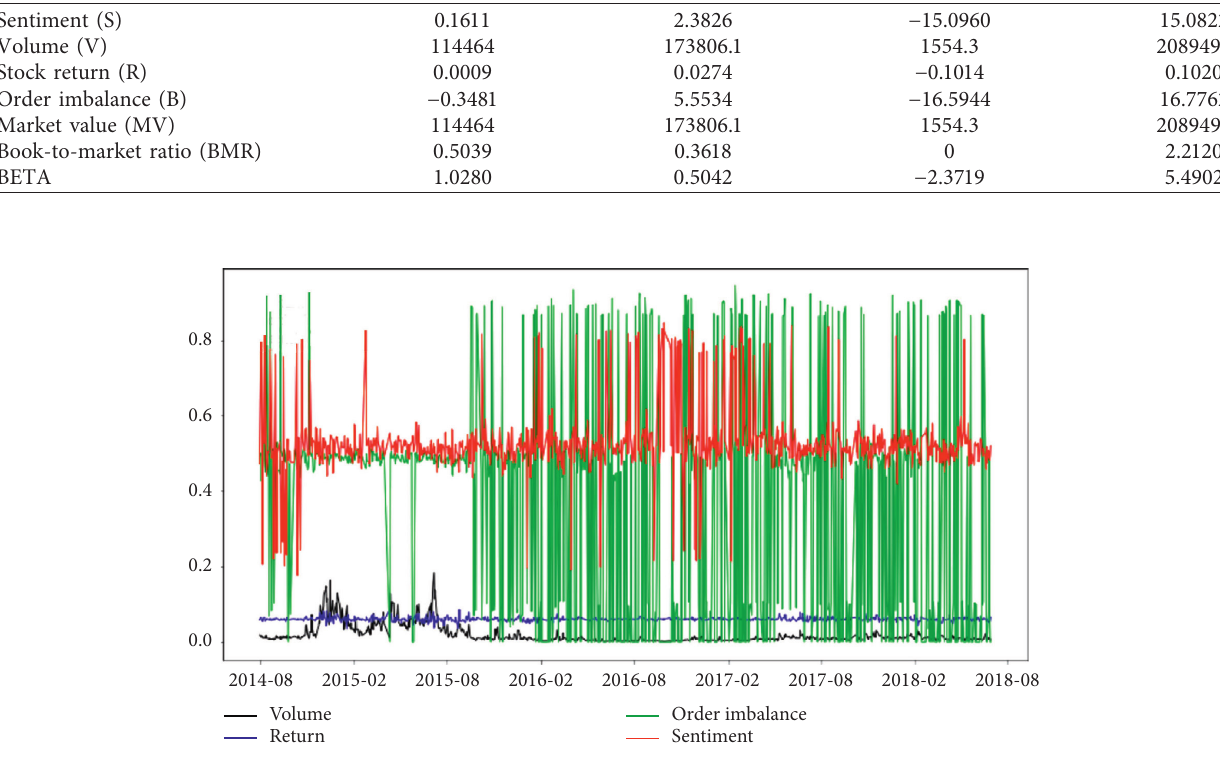
Figure 3: Historical trend of SH600036 (normalized). Table 3: Results of ADF test for